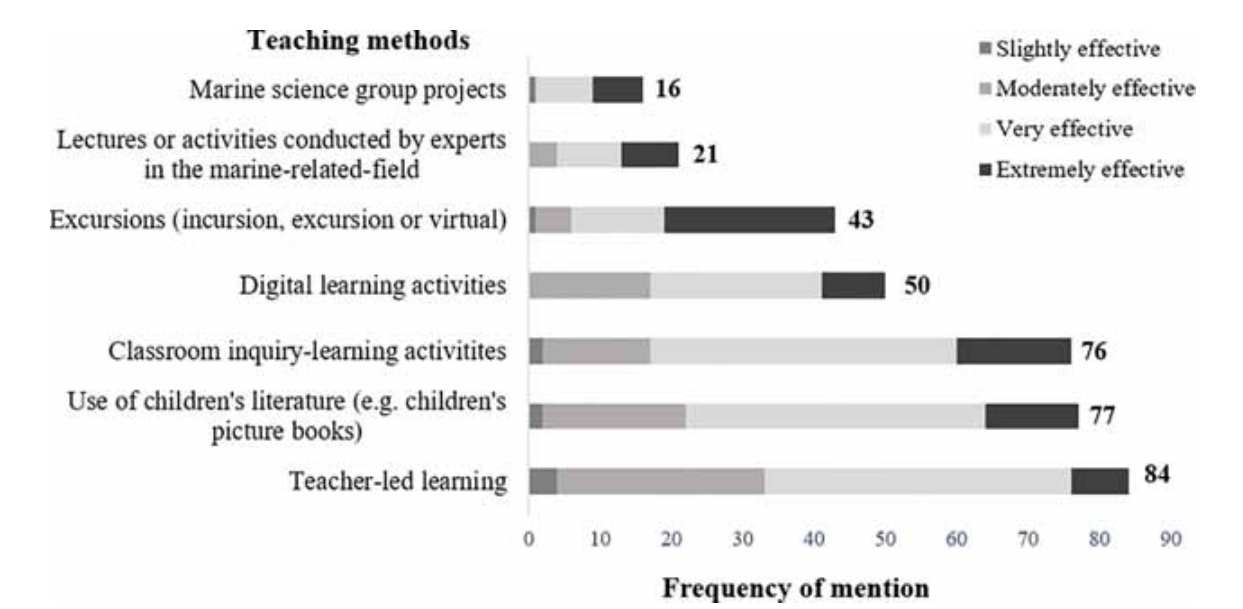
FIGURE 3 | Frequency of teaching methods used by teachers to educate about the ocean (scale) and the effectiveness of those methods according to teacher ’ s opinion